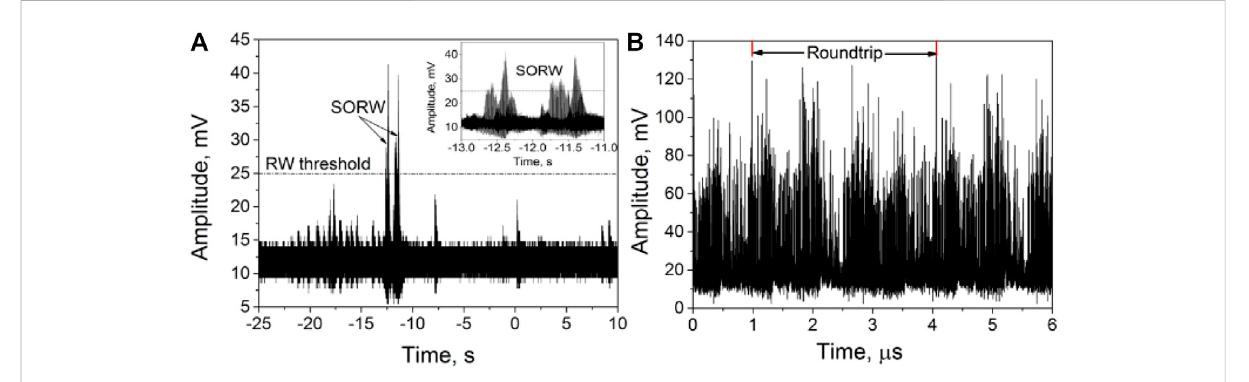
FIGURE 2 Oscilloscope traces of the (A) SORW and (B) FORW.